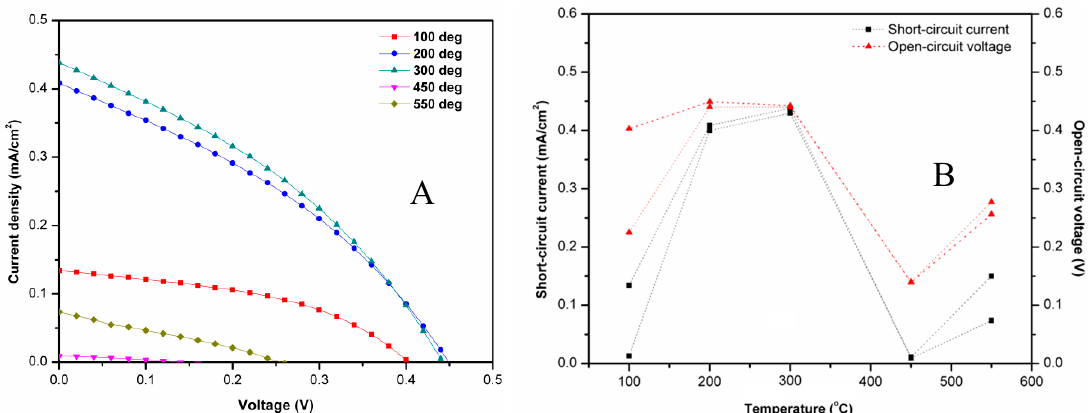
Figure 5. Device structure ( A ) and band structure illustration of annealed BiOI in different temperatures ( B ).